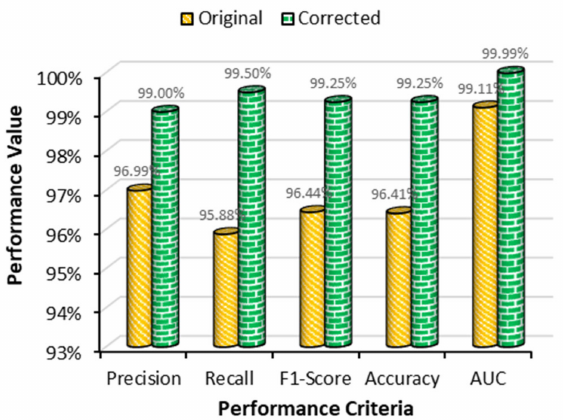
Figure 19. Performance comparison of original and modified datasets for the transformer-based model with SGD